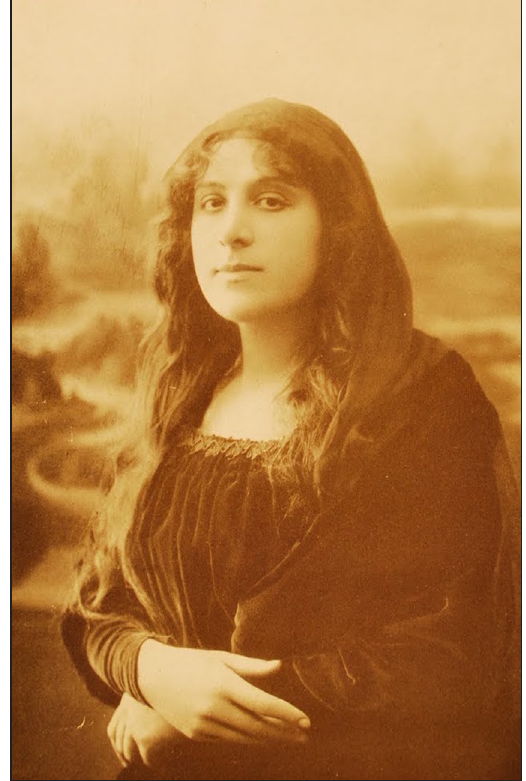
Fig. 13 : Lucy Arbell (Georgette Wallace) as La Joconde (the Mona Lisa ), Comoedia Illustré , Numéro spécial Noël, 1911, Collection D. Clair. Reproduced by kind per- mission of Hervé